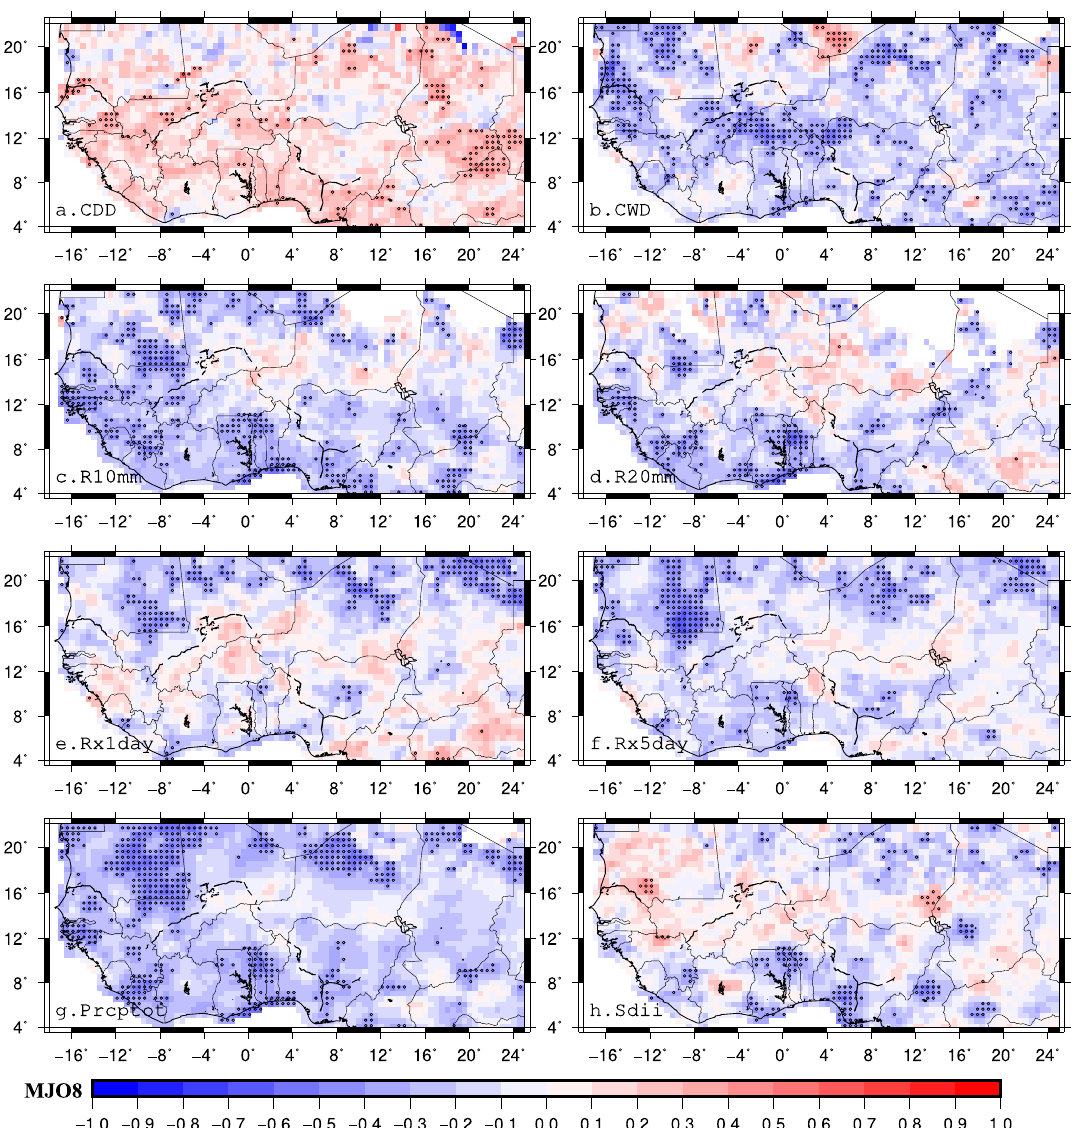
Figure 6. Correlation patterns between MJO8 and extreme precipitation indices. Tipping points represent significant correlation areas using EDOF. ( a ) CDD, ( b ) CWD, ( c ) R10mm, ( d ) R20mm, ( e ) Rx1day, ( f ) Rx5day, ( g ) Prcptot and ( h ) Sdii.